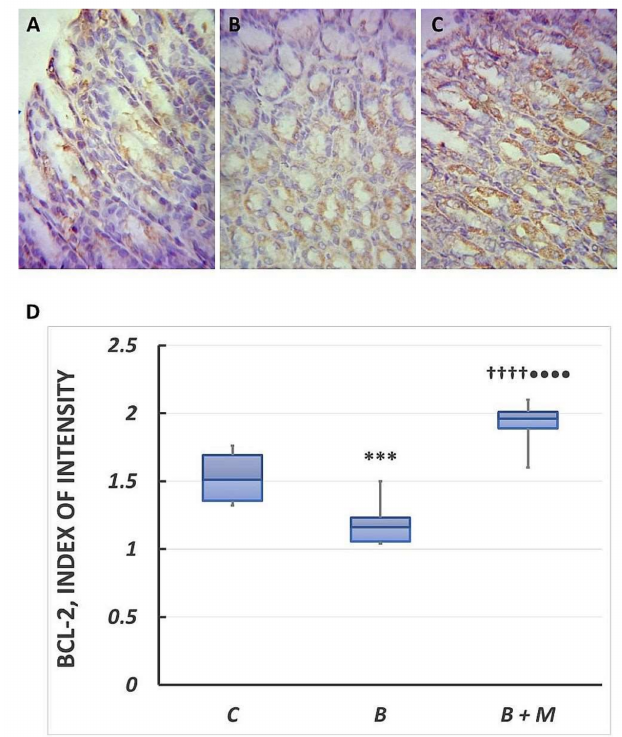
Figure 3. Melatonin effect on Bcl-2 expression. Immunohistochemical detection of Bcl-2 in gastric mucosa. Controls ( A ); burned rats ( B ); burned melatonin-treated rats ( C ). The antigen site appears as a brown color. Representative images. Original magnification, 400 × . Score index of Bcl-2 positive immunostained cells ( D ). Results are given as box plot, with median, 25th- and 75th-percentile values, and min and max values. *** p < 0.001 vs. control group; †††† p < 0.0001 vs. burned, non-treated group; •••• p < 0.0001 vs. control group. Controls (C); burned rats (B); burned melatonin-treated rats (B + M).